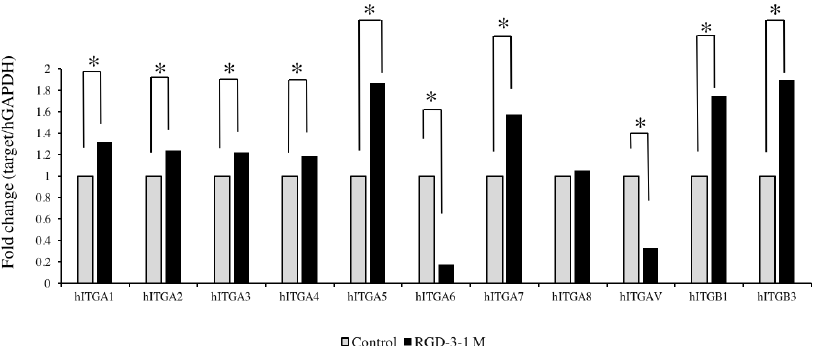
Figure 5. Effects of RGD-3 on the mRNA expression of various integrin subunit genes. Control represents cells cultured in the presence of β -GP, AA, and dH 2 O, RGD-3 group represents cells cultured in β -GP, AA, and 1 M RGD-3. All the integrins showed enhanced mRNA expression compared to the control. Among them, the mRNA expression of hITGA5 , hITGA7 , hITGB1 and hITGB2 exhibited strong promotion. n = 3. ∗ Denotes significant difference when compared to the control ( p < 0.05 vs. control).